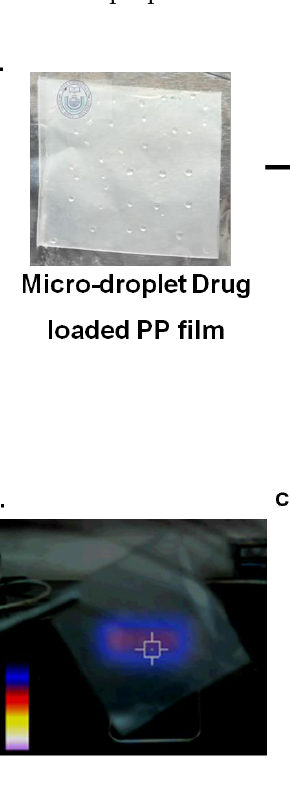
Figure 1. ( a ) The FT-IR transmission peaks of bare PP film, dye (ICG)-loaded PP film, and lido- caine-loaded PP film. The scanning electron microscopic (SEM) images (scale bar 1 µm) of ( b ) bare